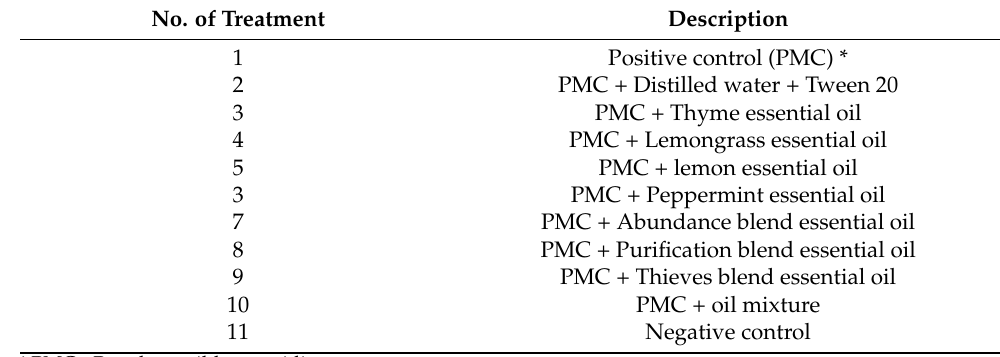
Table 1. Number and description of